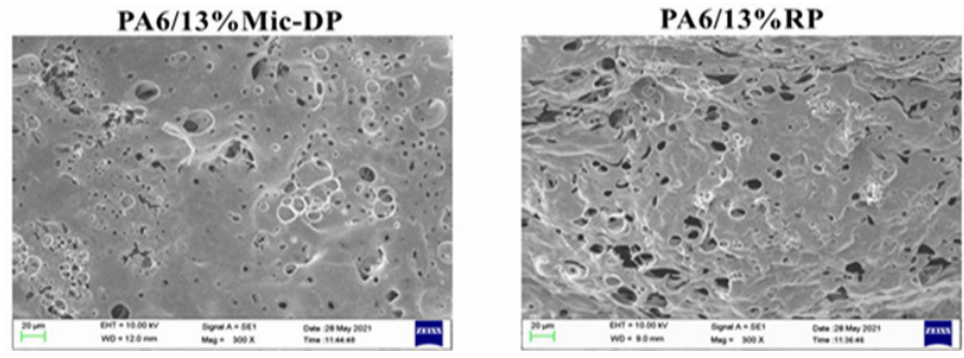
Figure 6. Photographs of residual chars from PA6 samples.